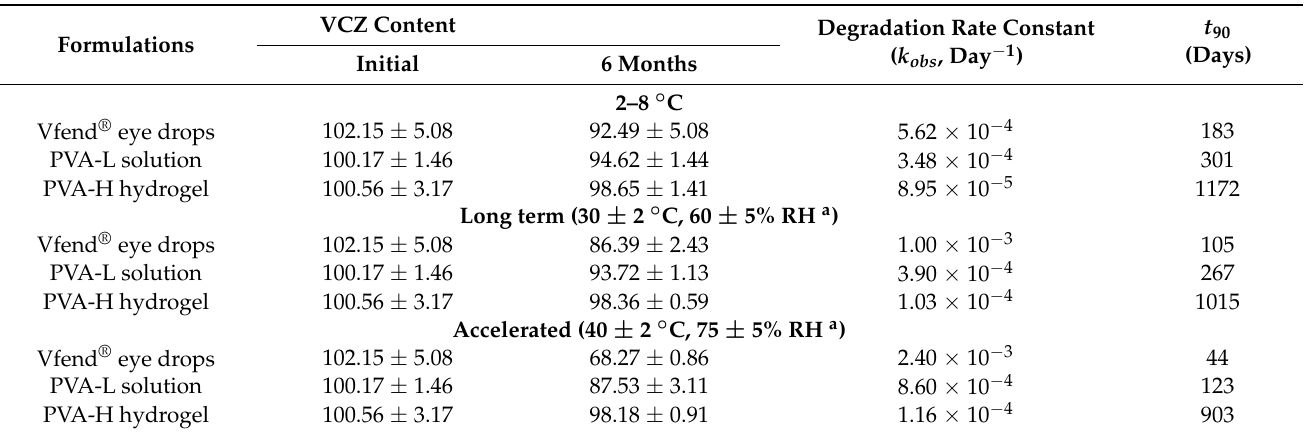
Table 8. Drug content, degradation rate constants and shelf-lives of Vfend ® eye drops and VCZ eye drop formulations stored for up to 6